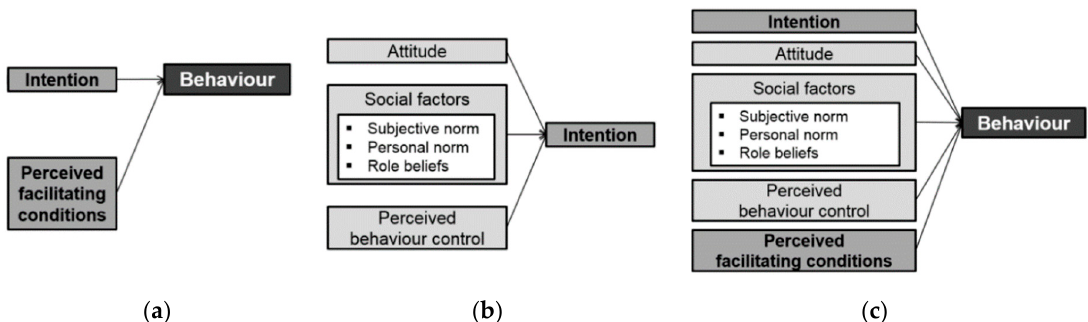
Figure 5. Three models tested using logistic regression: ( a ) First model to explain behaviour (frequency of upcycling); ( b ) second model to explain intention; ( c ) third model to explain behaviour based on all factors [14,15].